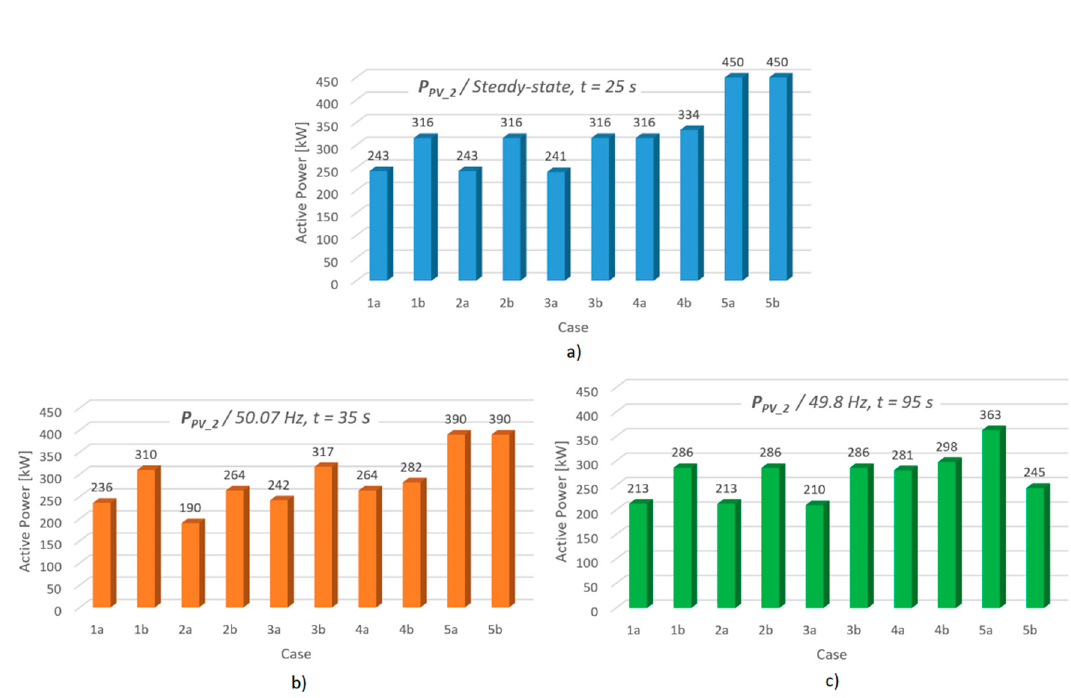
Figure 4. PV 2 ′ s active power ( P PV_2 ) values in different cases with very low load during ( a )